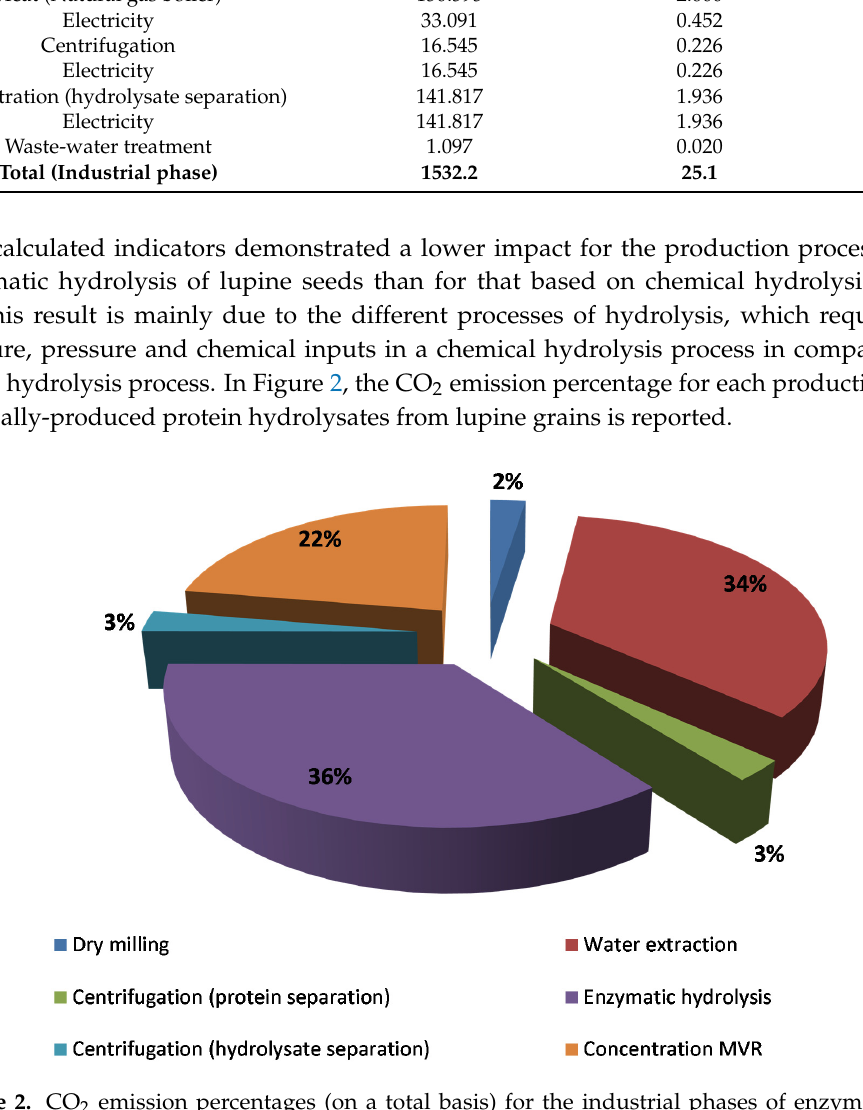
Figure 2. CO 2 emission percentages (on a total basis) for the industrial phases of enzymatically- produced protein hydrolysate from lupine grains.